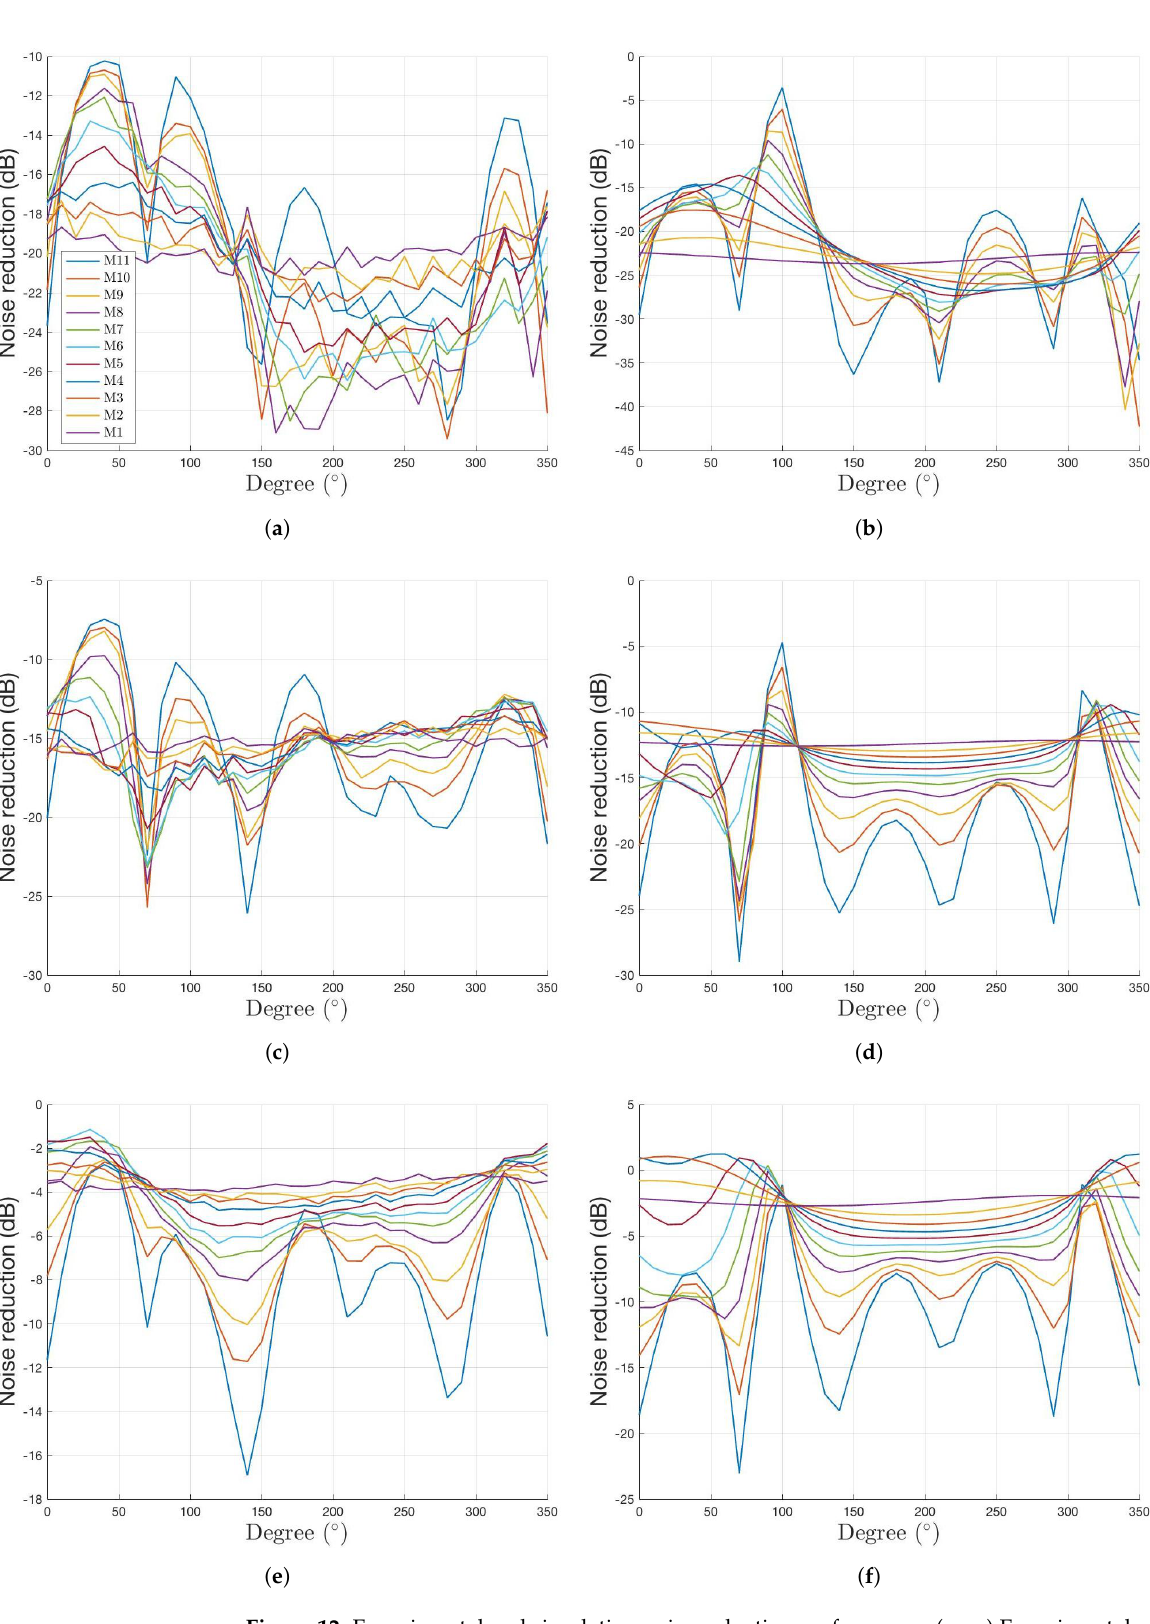
Figure 12. Experimental and simulation noise reduction performance. ( a , c , e ) Experimental cases 1, 2, and 3, respectively, and ( b , d , f ) simulation cases 1, 2, and 3,